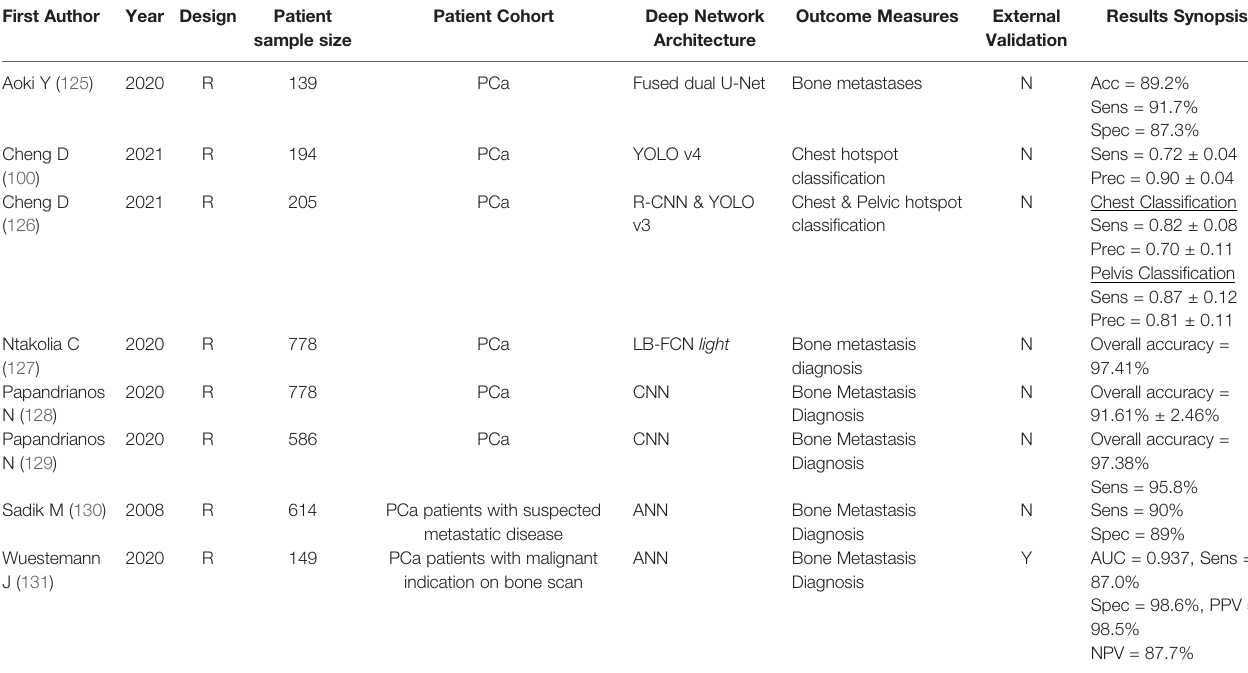
TABLE 5 | Prominent characteristics of identi fi ed mPCa studies using deep radiomics methodology on bone